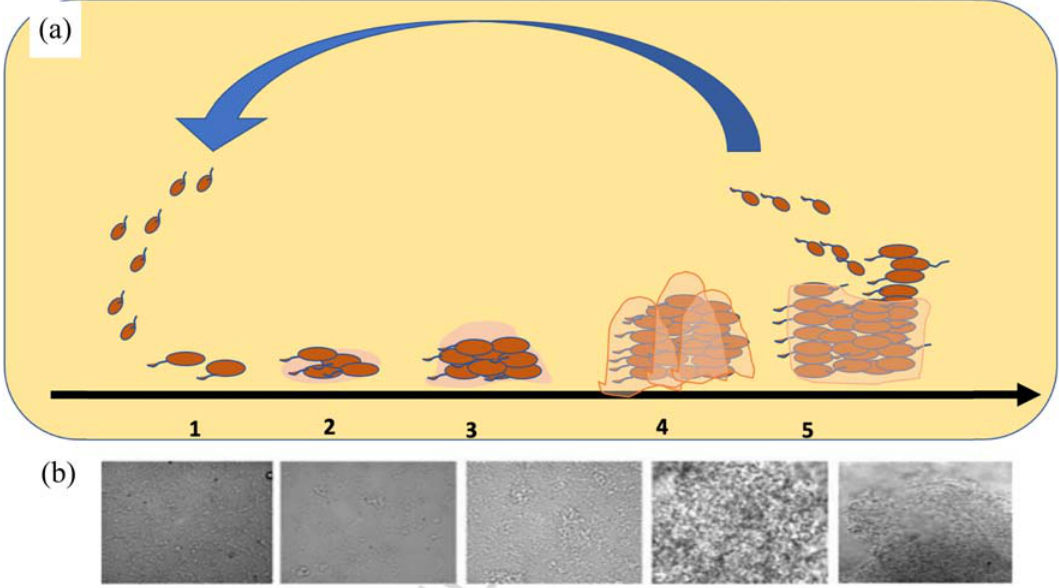
Figure 1: ( a ) Development and dispersion of bio fi lm life cycle stages before becoming biofouling and ( b ) electron micrographs of bio fi lm life cycle stages [ 31 ]